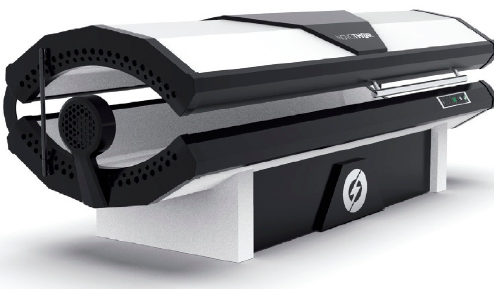
Figure 1. PBM bed by NovoTHOR. Table 1. Specifications of NovoTHOR bed.